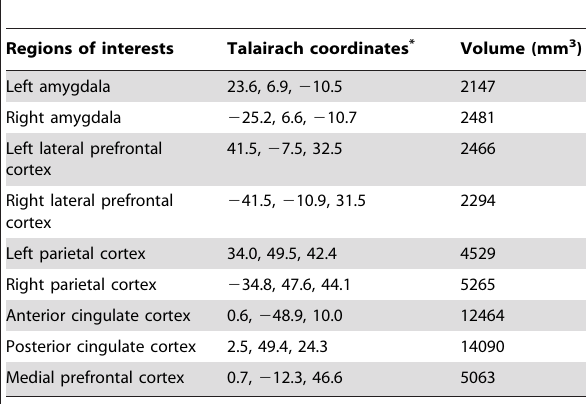
Table 1. The regions of interest defined from task